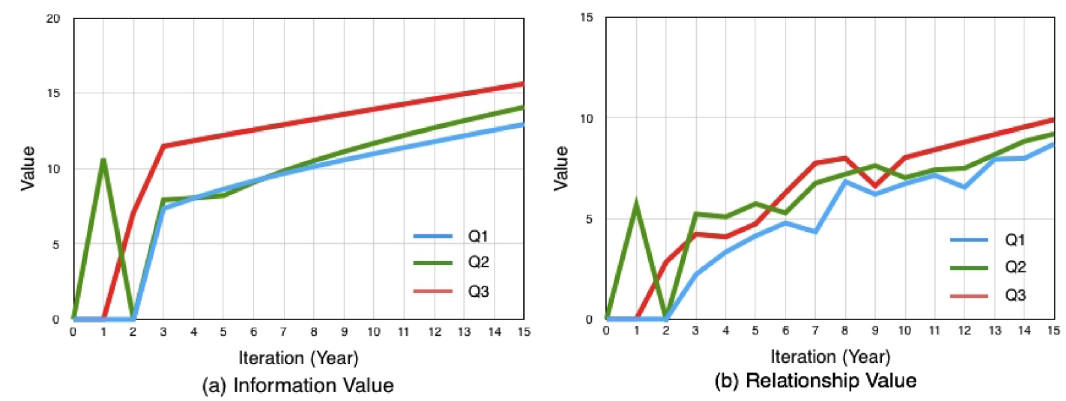
Figure 4. Value Generated in Preparation Stage: (a) Information Value, (b) Relationship